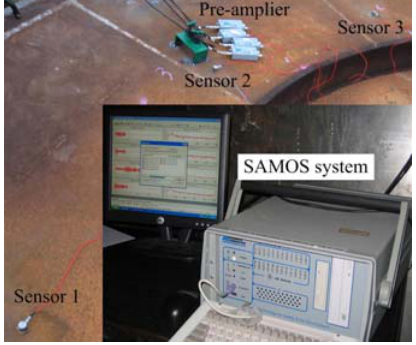
Fig. 4 The first twenty eigenvalues of kernel